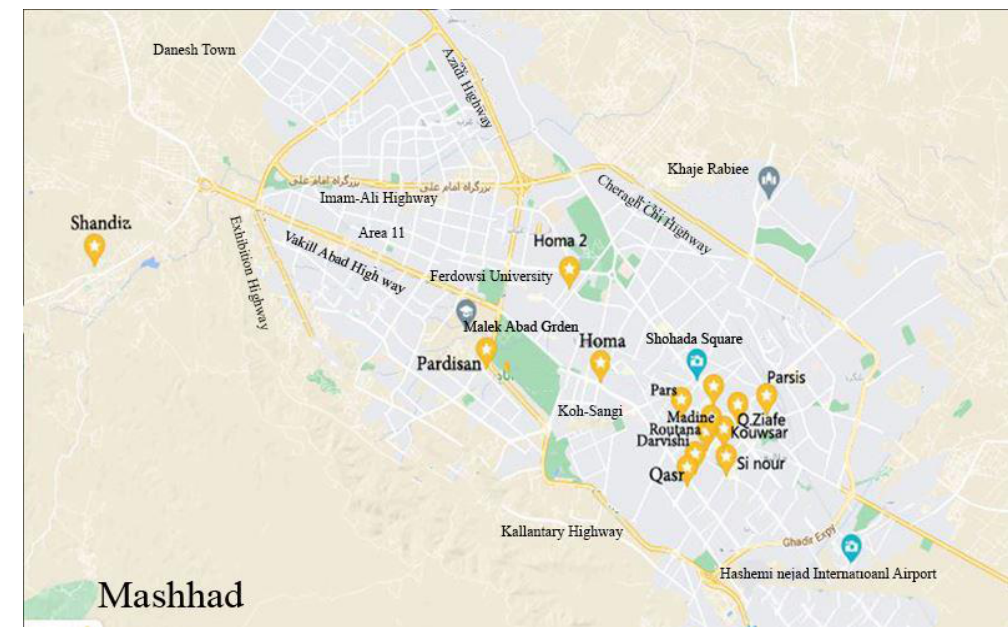
Fig. 5 : Location of the studied hotels in Mashhad